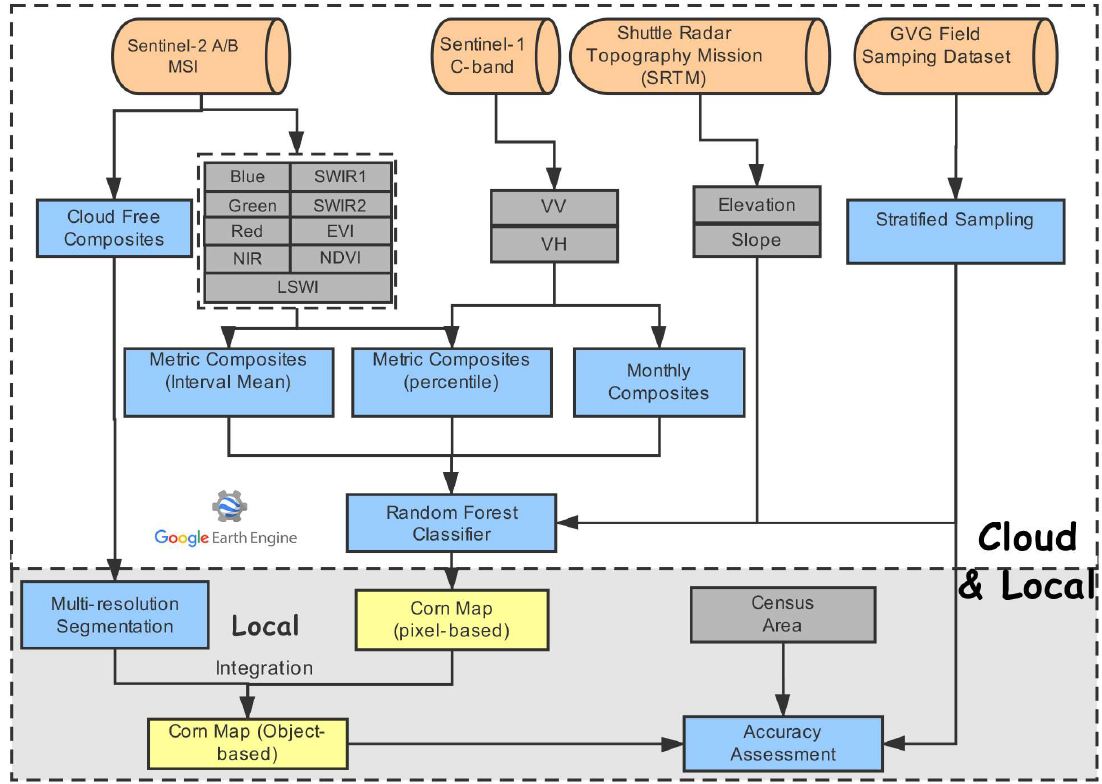
Figure 4. Workflow for cloud computing-based methods using optical and synthetic aperture radar (SAR) images. The pixel-based classification of corn using random forests (RFs) with composite metrics and the integration between pixel-based results and multiresolution object-based segmentation were the two major modules.